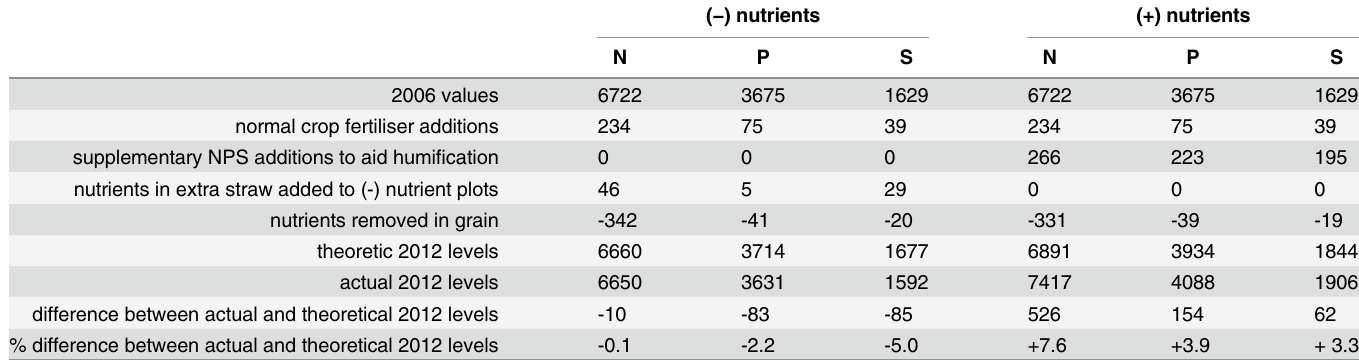
Table 4. N, P, S balance (kg ha -1 ) for the ( − ) and (+) supplementary nutrient treatments in 2012 compared to the 2006 starting values.